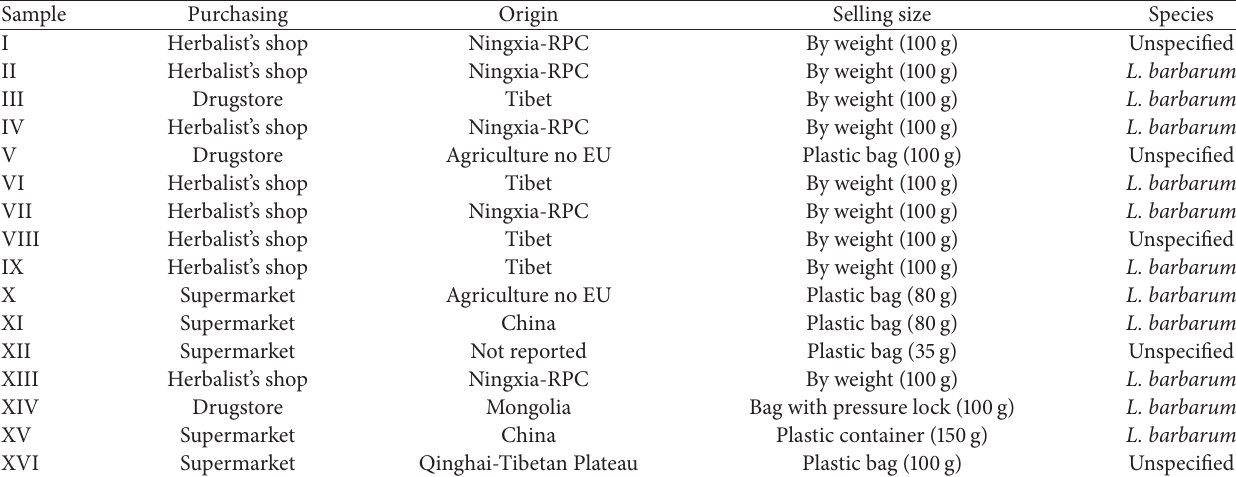
Table 1: Goji berry